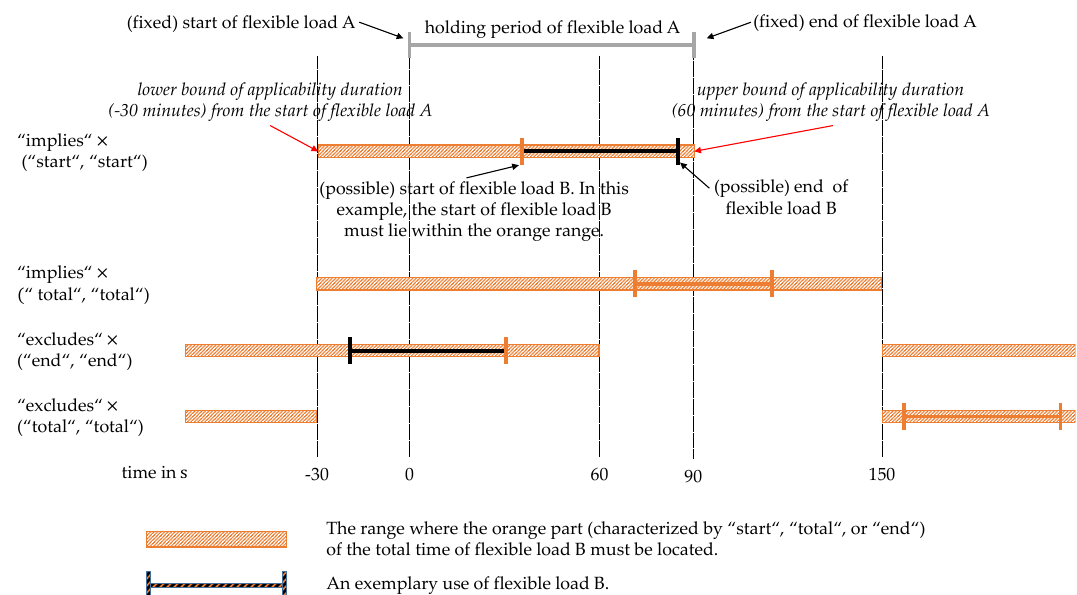
Figure 4. Logical type, temporal type, and applicability